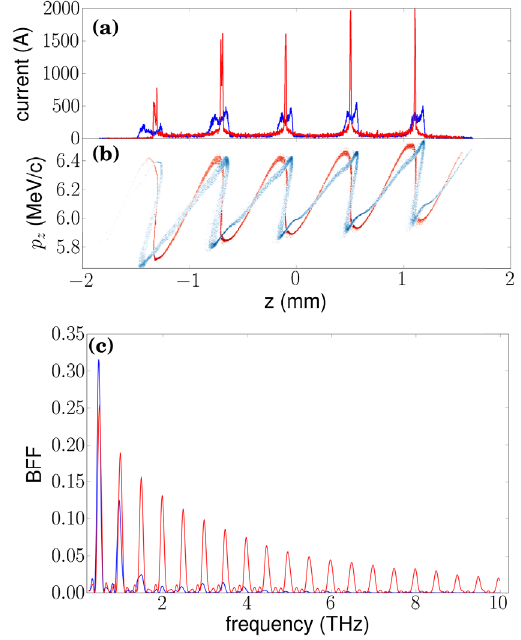
FIG. 7. Current profiles (a) and associated longitudinal phase spaces (LPS) (b) simulated at maximum compression 31 cm downstream of the DLW (red traces) and at the location of slight overcompression 52 cm downstream of the DLW. Bunch form factor (BFF) (c) obtained at the similar locations. The simulations correspond to the parameters listed under the S-band column in Table I with the exception of the geometric parameters of the DLW structure selected to be a ¼ 350 μ m, and b ¼ 393 μ m.